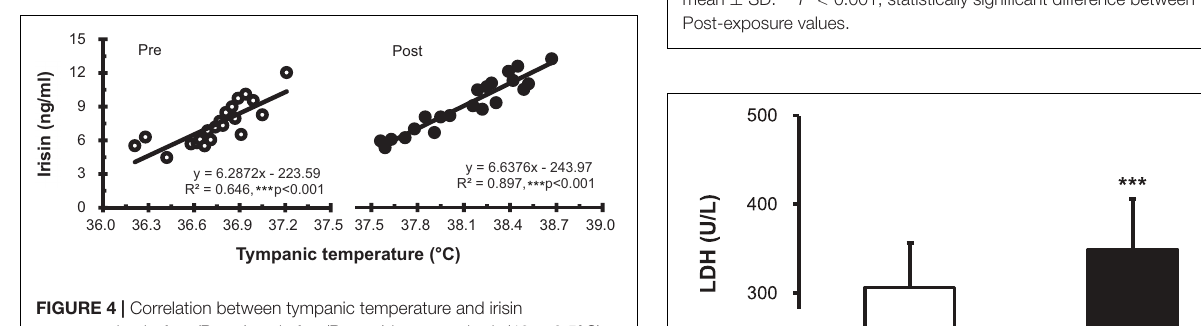
FIGURE 4 | Correlation between tympanic temperature and irisin concentration before (Pre; ◦ ) and after (Post; • ) hot water bath (42 ± 0.5 ◦ C) immersion. *** P < 0.001, statistically significant difference (Pre; R 2 = 0.646, Post; R 2 = 0.897).